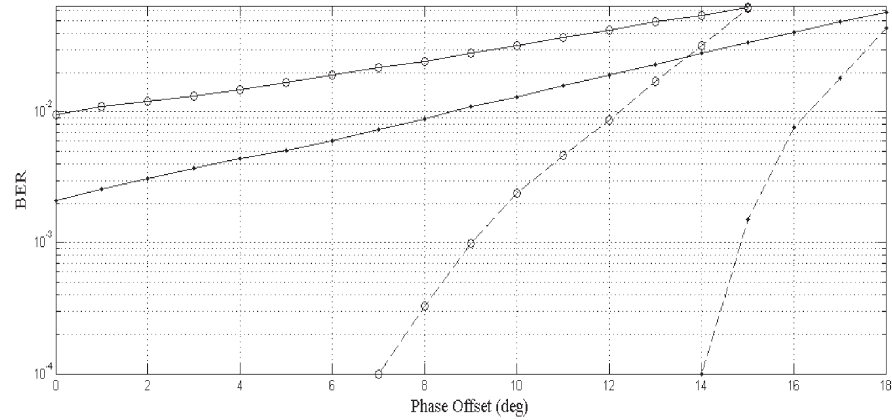
Fig. 4. Dependence of error probability for BPSK modulation scheme on phase offset in the uplink and the downlink: dots indicate values without coding, circles – with convolutional coding (rate ¾, constraint length K = 7); satellite and ground receivers noise temperatures is at 20 K (dots, free space path loss 162 dB) and at 290 K (circles, free space path loss 157 dB); HPAs backoff level amounts to 7 dB; frequency offset is equal to zero; d 1 = d 2 = d 3 = d 4 = 1.0 m; satellite transponder phase noise is